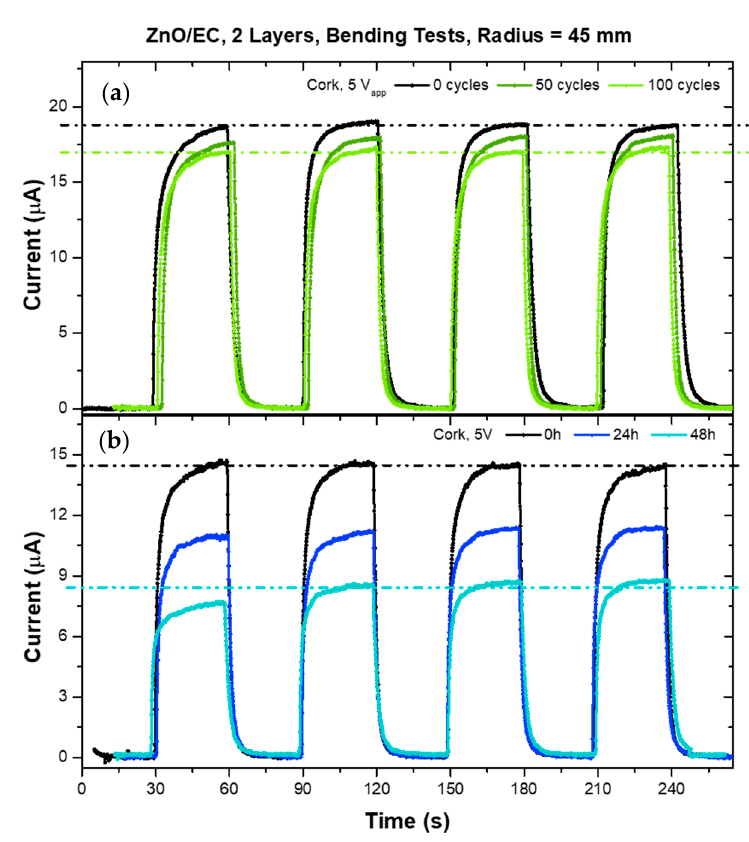
Figure 7. ( a ) Photoresponses during cyclic bending deformation using a cylinder with a 45 mm radius; ( b ) Photoresponse for a fixed curvature over time on the same test cylinder.